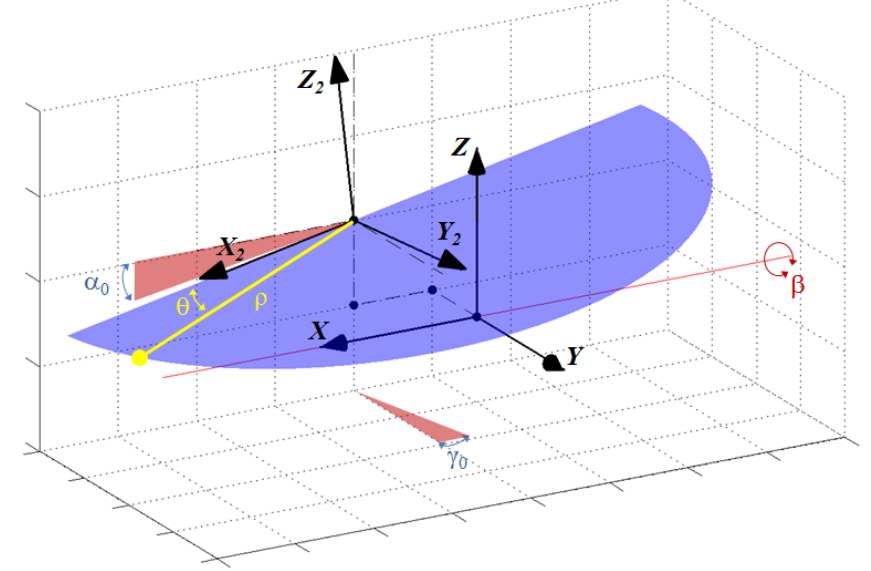
Figure 2. Misalignments between the 2D sensor frame and the 3D sensor